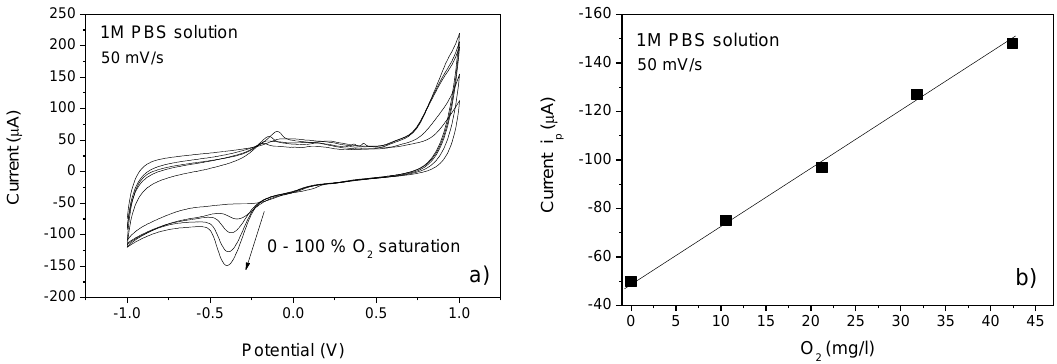
Figure 1. ( a ) Cyclic voltammograms obtained in presence of different oxygen concentration and recorded in the potential range from −1 to 1 V at a scan rate of 50 mV/s; ( b ) current-oxygen concentration behavior, obtained from cathodic peak at −0.4 V.